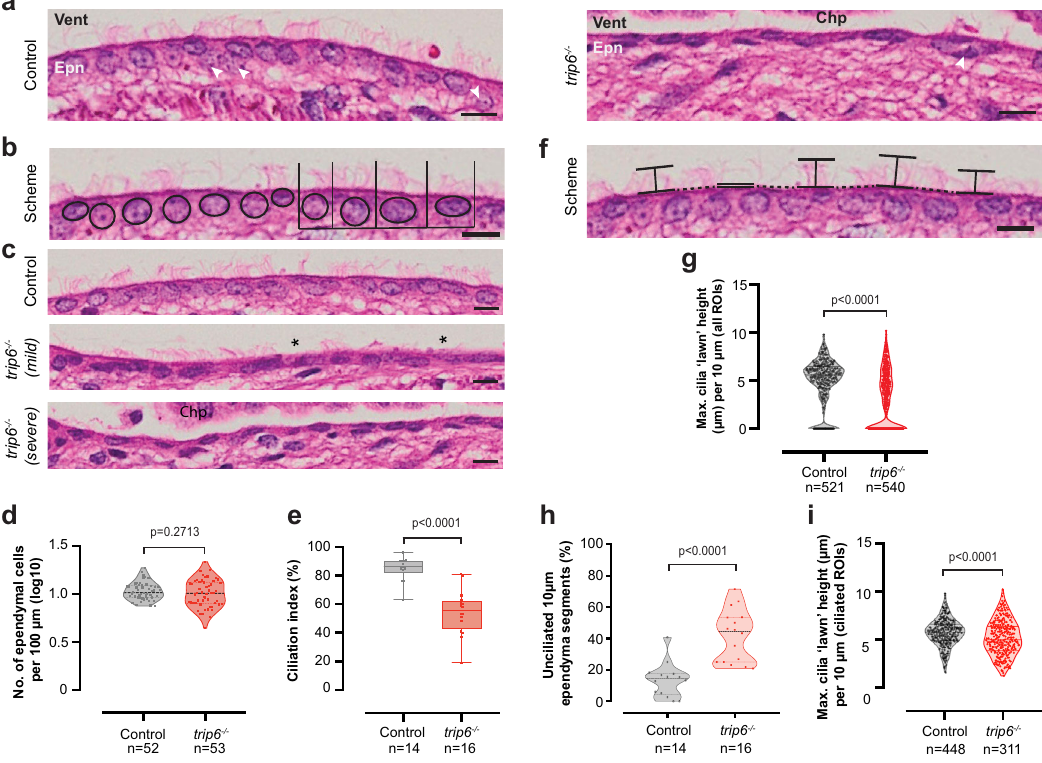
Fig. 3 Histological characterization and quanti fi cation of periventricular ependymal cells and their cilia. a Representative images of H&E stained ependyma, comprising ependymal cells (Epn) and interspersed basal cells (arrowheads), lining the 4th ventricle (Vent) in trip6 + / − (Control) and trip6 − / − mice. Note the poorly differentiated epithelial layer comprising atrophic ependymal cells that exhibit “ endothelial ” ( fl attened) cell morphology and aberrant ciliation, as well as the relative sparsity of basal cells in the trip6 − / − brain. b Semi-schematic depiction of the segmentation method used in cell number and ciliation index quanti fi cation of the ependyma. Individual ependymal cells were determined by their nuclei (circles) and inspected for the presence of cilia on their apical site (lines). c Representative images depicting native, mild and severe phenotypes for cell number and ciliation of control and trip6 − / − mice. Quanti fi cation demonstrated that although the mean number of ependymal cells was not altered ( d ), ciliation is signi fi cantly affected ( e ). [The box plot ( e ) indicates the median (middle line), the interquartile range from 1st to the 3rd quartile (box) and the range of the minima to maxima (whiskers)]. f Semi- schematic depiction of the method used for quanti fi cation of cilia length and coverage of the ependyma. Individual segments of 10 µ m were determined (horizontal full and dotted lines) and maximum cilia “ lawn ” height was measured at each second segment (vertical lines) for quanti fi cation and found to be reduced in trip6 − / − mice ( g ). The coverage of cilia (indicated as the fraction of unciliated segments per 100 µ m) is signi fi cantly reduced in trip6 − / − mice ( h ). The length of cilia (determined as maximum cilia “ lawn ” height per 10 µ m ciliated segment) was also signi fi cantly reduced ( i ). Further information on quanti fi cation methodology and statistical tests performed can be found in “ Methods ” section (including Supplementary Table 7). The statistical signi fi cance of the analyses is represented by the p -values indicated in the graphs ( e , d , g , b , h , i ). Source data are provided as a Source Data fi le. Chp choroid plexus. Asterisk (*) indicates unciliated areas. Scale bars: 10 µ